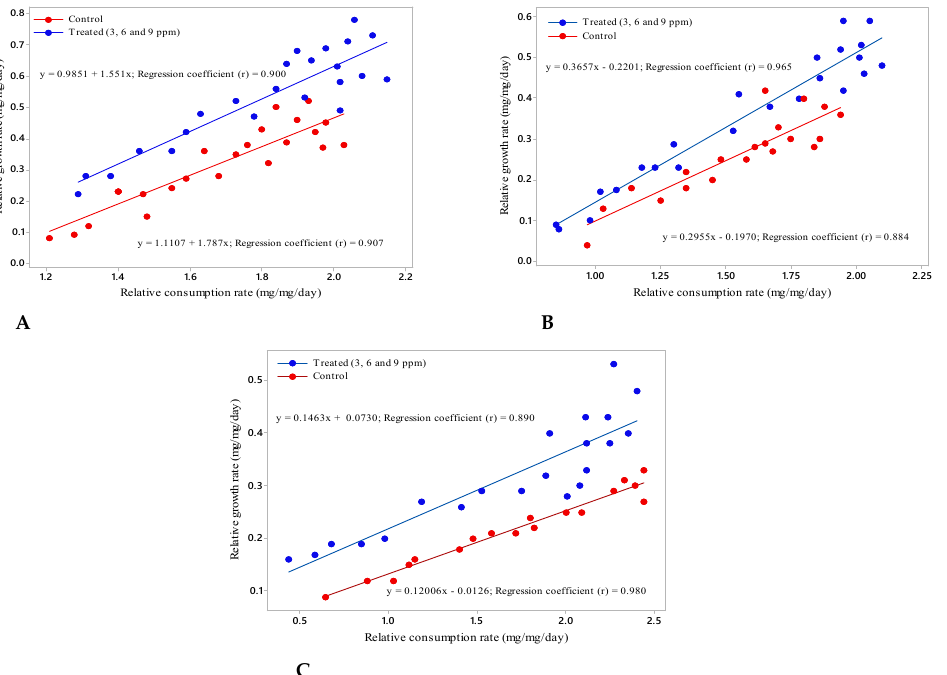
Figure 2. Regression equation and correlation between relative growth rate and relative consumption rate of ( A ) third ( B ) fourth ( C ) fifth instar larvae of S. litura fed on leaves containing andrographolide with different concentration.